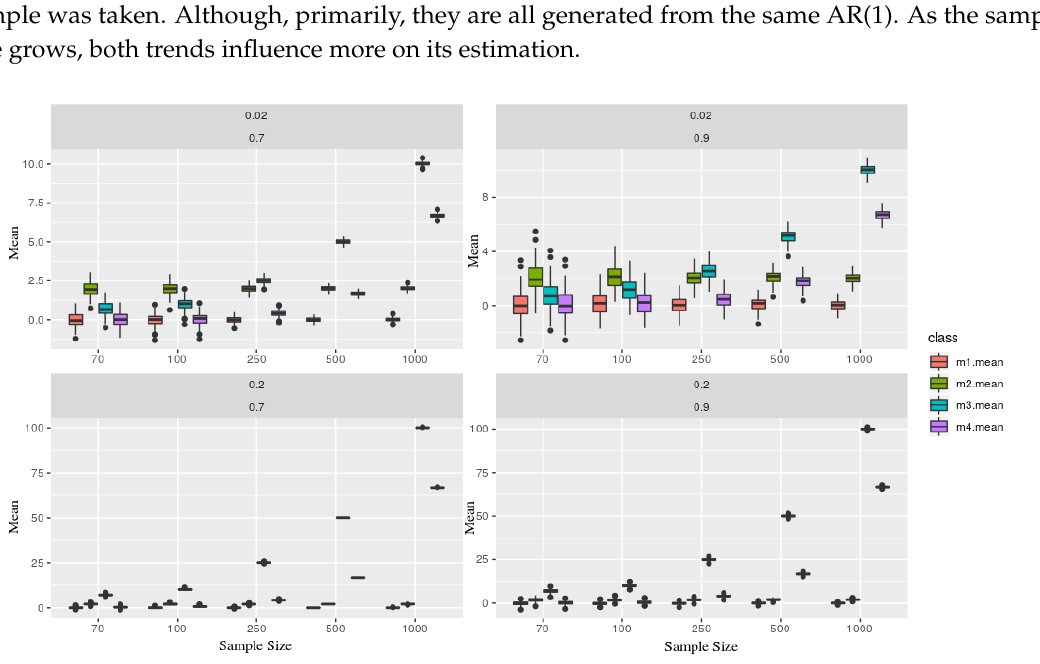
Figure 2. Each figure represents a simulated series, which contains two parameters γ = 0.02,0.2 and φ = 0.7,0.9 (in the top of each board). Each class (color) is associated with a given model, where as the sample size (x-axis), and y-axis the mean statistic. Models x1 and x2 are presents more stochastic components than x3 and x4, therefore one can not recognize through its